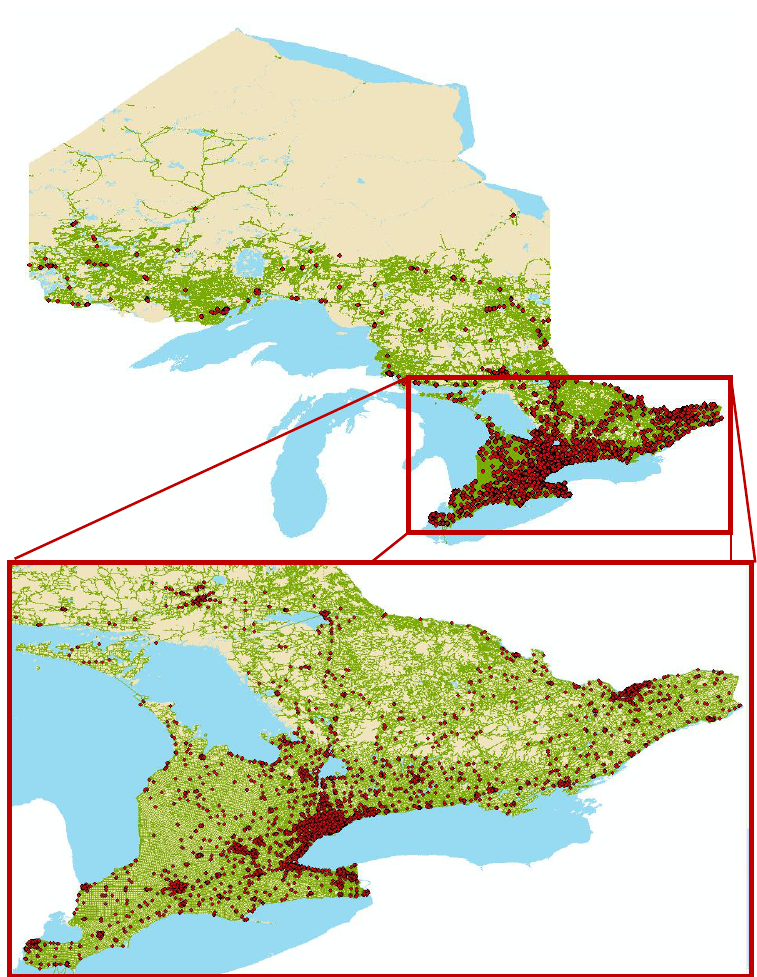
Figure 1. Map of tobacco retailers in Ontario, with enlarged view of southern Ontario.